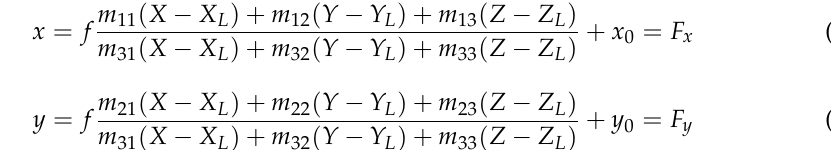
Figure 3. Object and camera frame geometry of SVGS. The image plane is shown in blue. v kMv , where k is a scaling factor and M is a rotation Both vectors are related by a A matrix representing an x, y, z rotation sequence transforming the object frame to the image frame. Dropping the “ a ” and “ A ” subscripts and solving for the image frame coordinates x , y , and z of point “a”, followed by dividing by “ z ” to eliminate the scaling factor k , yields the following two equations for F x and F y , where the m ij values are elements of the direc ‐ tion cosine matrix M :